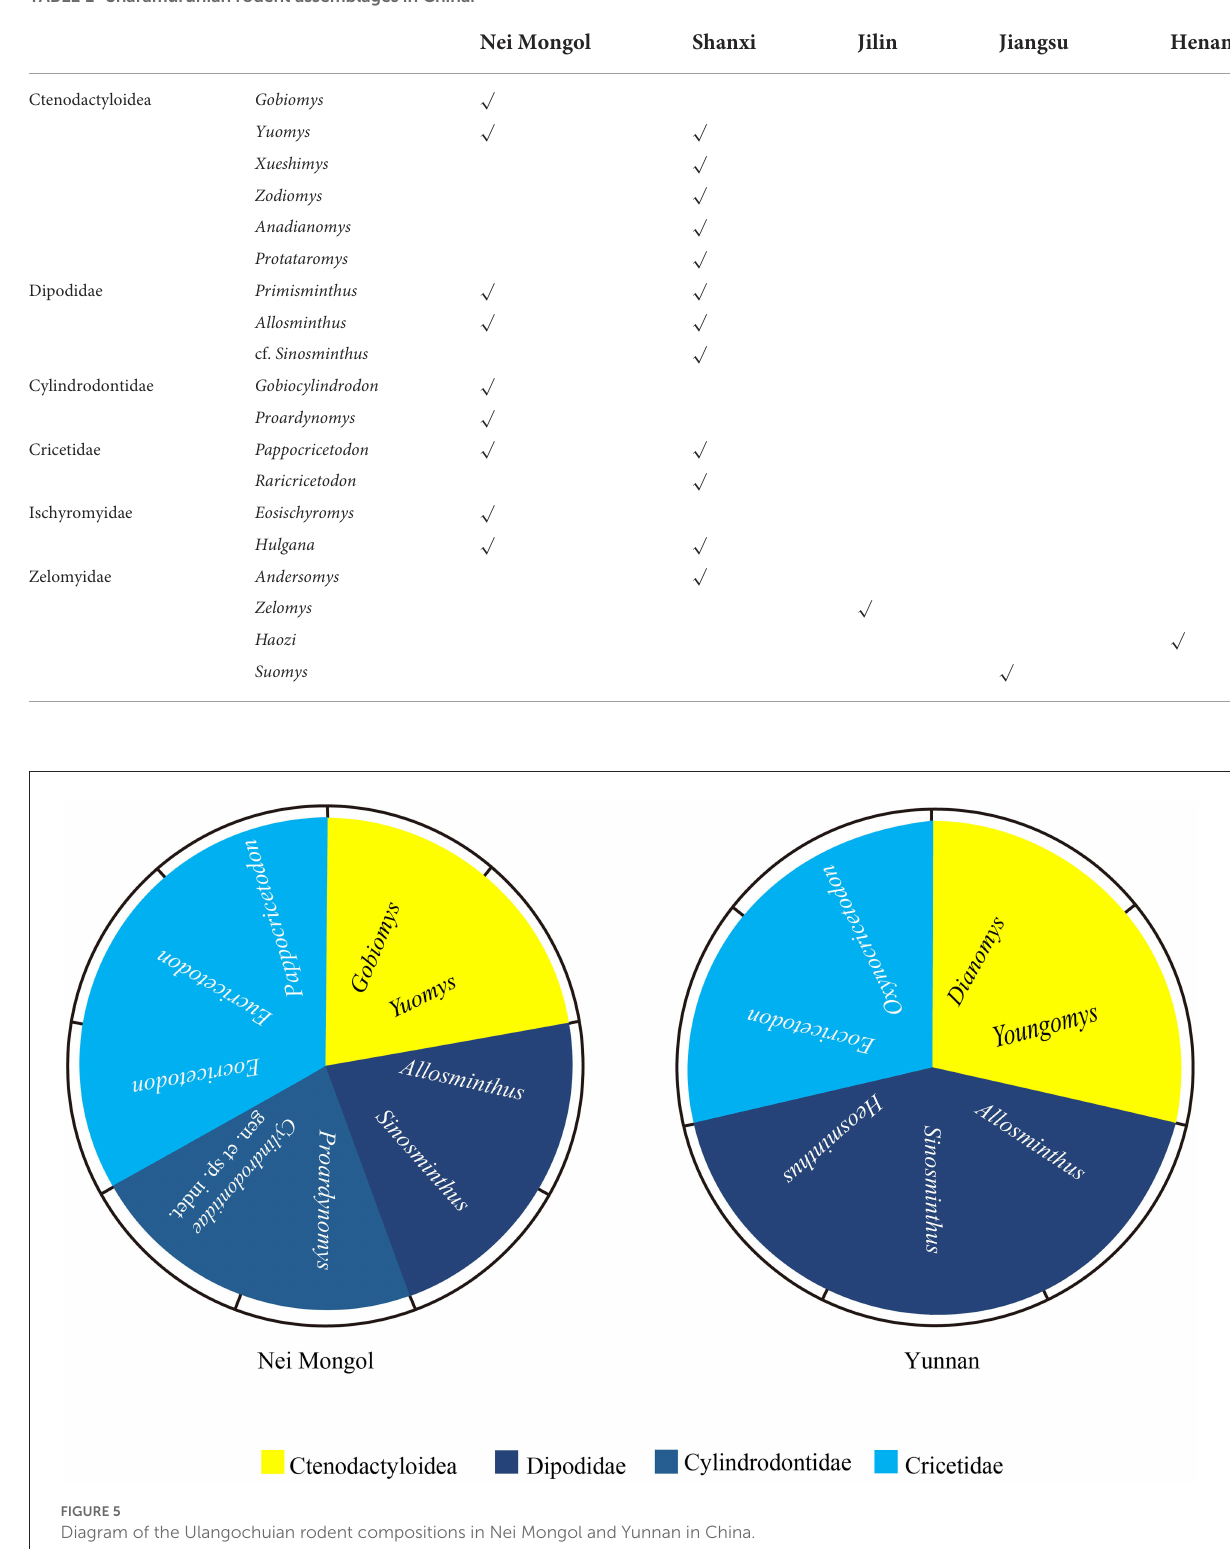
TABLE 1 Sharamurunian rodent assemblages in China.